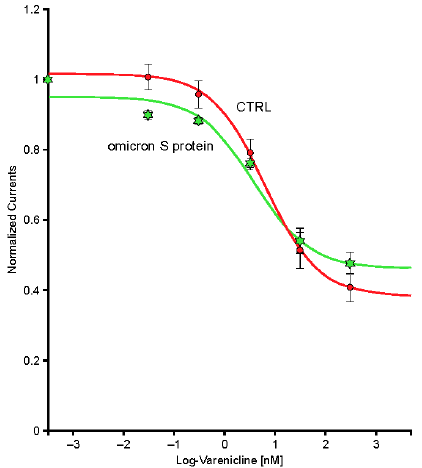
Figure 12. Peak inward currents evoked by 50-µM acetylcholine were recorded in a series of cells Figure 10. Peak inward currents evoked by 50- µ M acetylcholine were recorded in a series of cells for for control ( n = 9; red) and during exposure to 10-µg/mL omicron S protein ( n = 9; green) and control ( n = 9; red) and during exposure to 10- µ g/mL omicron S protein ( n = 9; green) and normalized to unity vs. the response recorded in control. Continuous lines are the best fits obtained with the Hill equation. log,